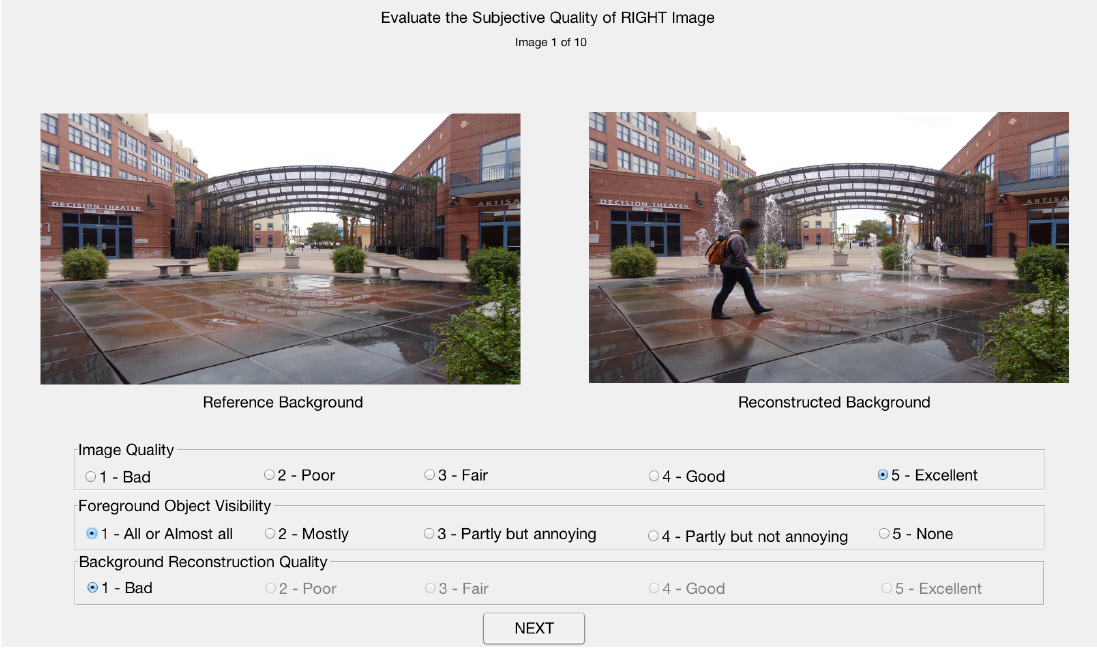
Figure 3. Subjective test Graphical User Interface